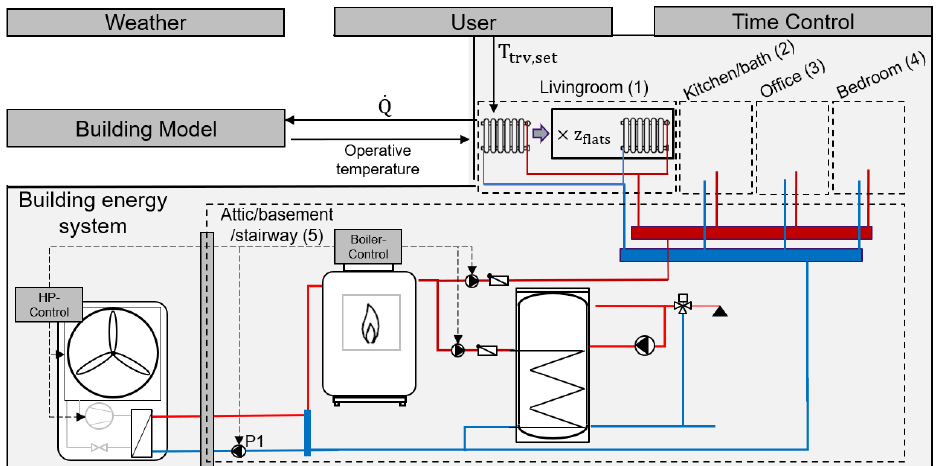
Figure 5. Building simulation model